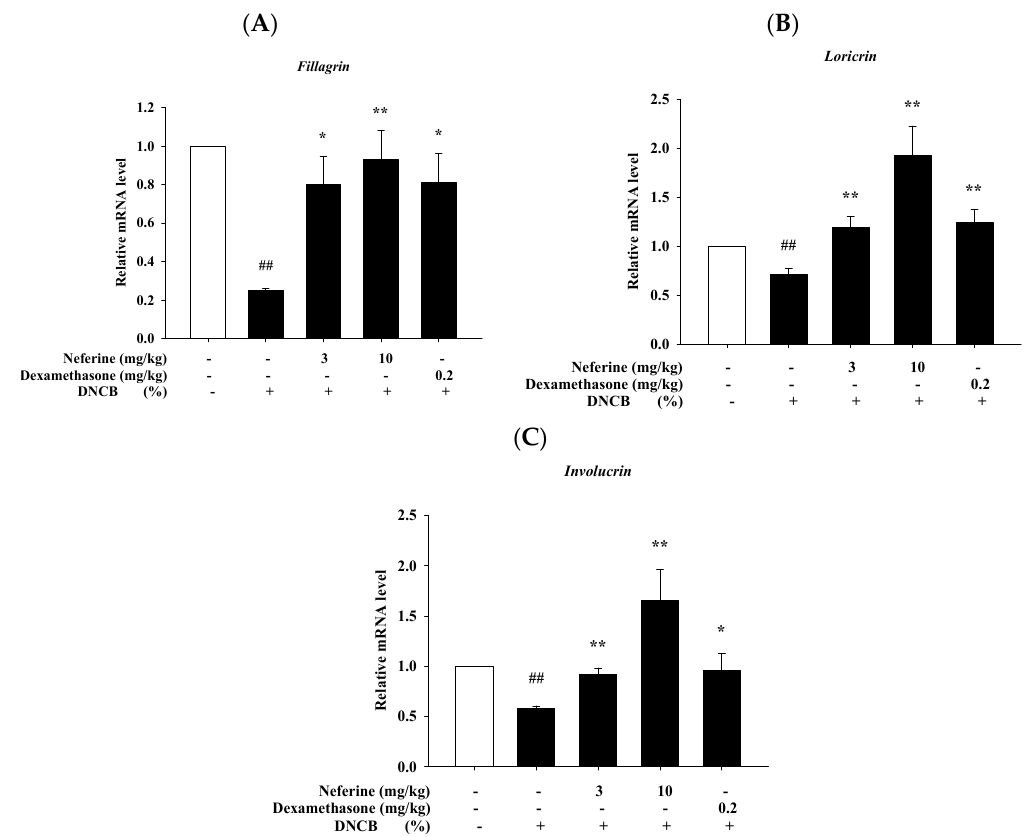
Figure 8. Effect of neferine on barrier-related molecules’ mRNA expression of atopic dermatitis-like phenotype in BALB/c mice. ( A ) Filaggrin, ( B ) loricrin, ( C ) involucrin. Values represent the mean ± SEM from the three independent experiments. ## p < 0.01 compared with the no-treatment condition, * p < 0.05, ** p < 0.01 compared with the only DNCB treatment condition.